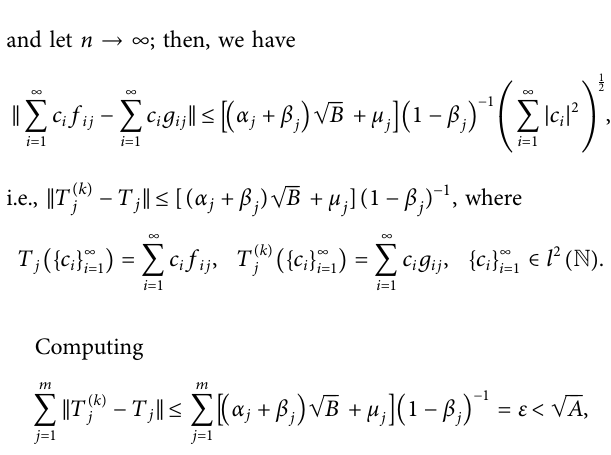
| j ∈ [ m ]} is woven (cid:10)(cid:10) √ i (cid:2) 1 − ε ) 2 A